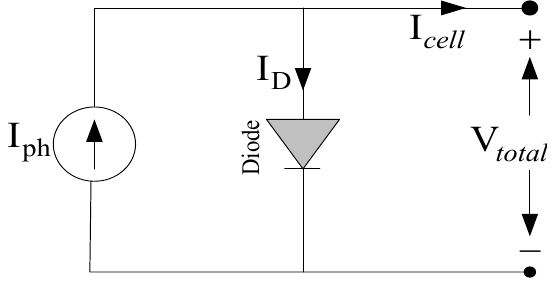
Figure 3. Equivalent circuit of solar cell